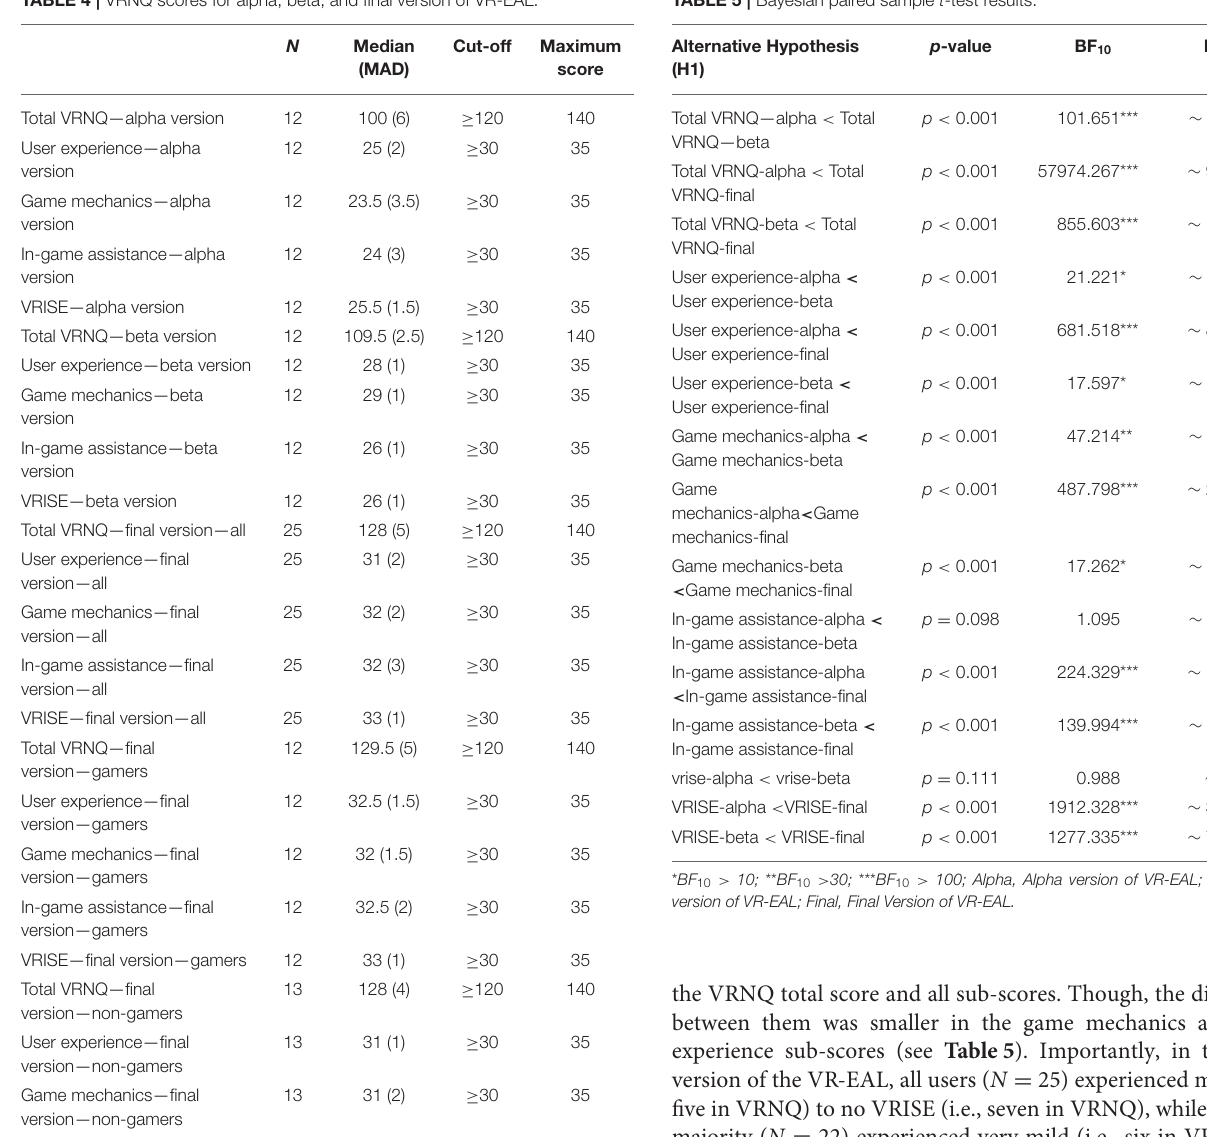
TABLE 4 | VRNQ scores for alpha, beta, and final version of VR-EAL. TABLE 5 | Bayesian paired sample t -test